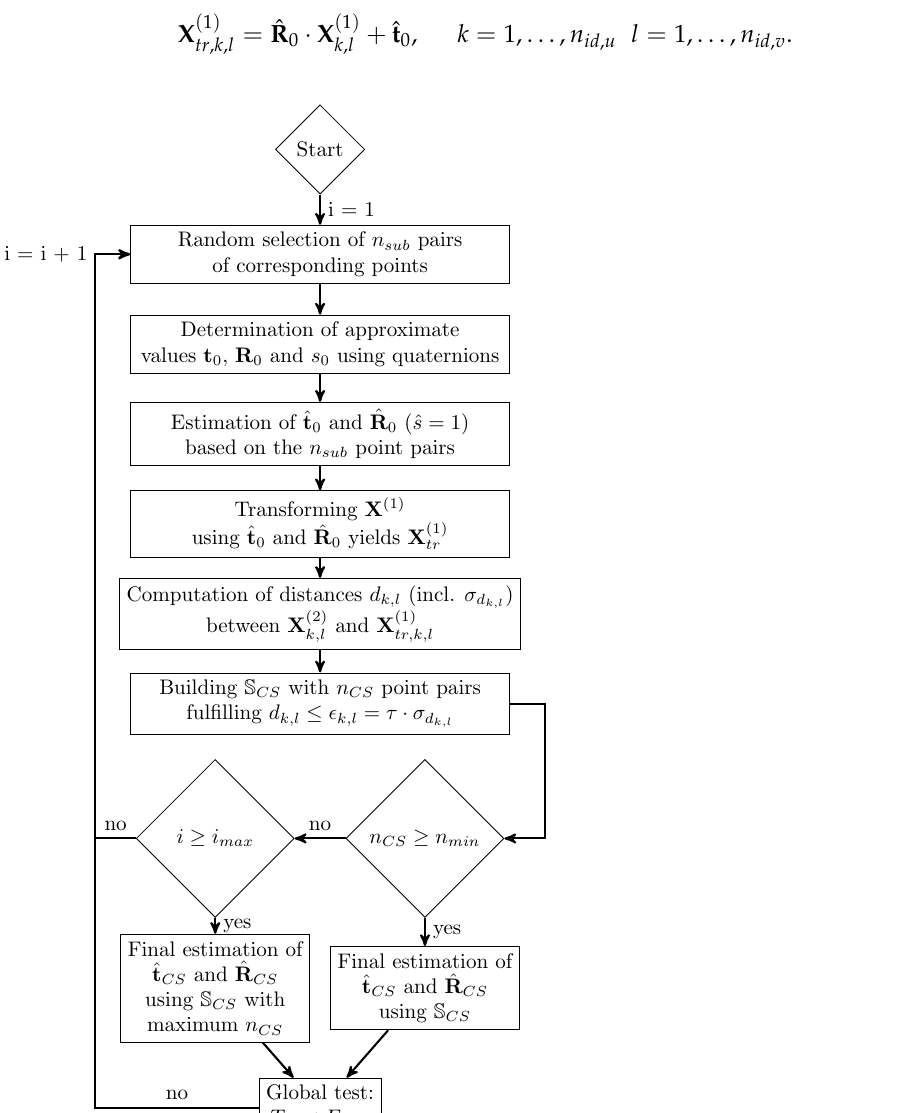
( 1 ) belonging to epoch E 1 and its corresponding point tr , k , l